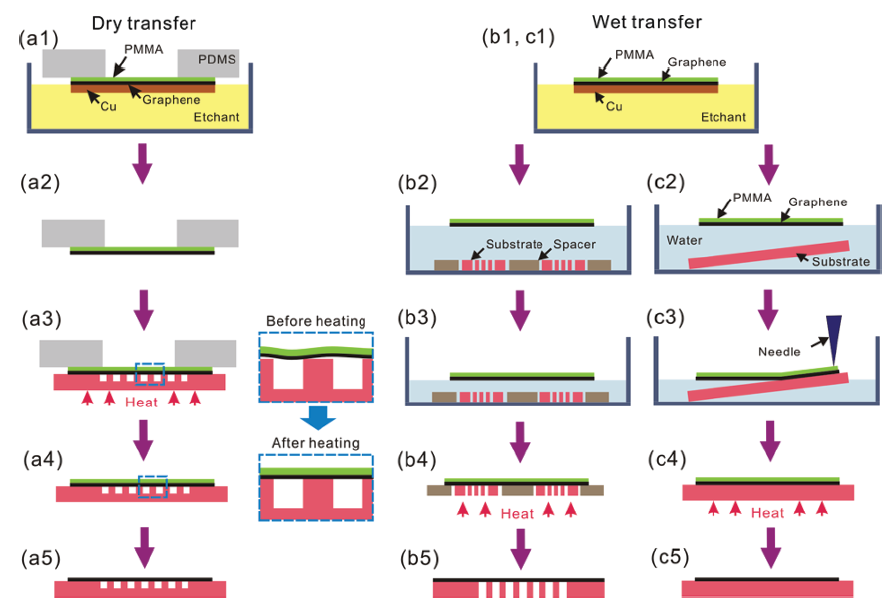
Figure 13. Schematic illustration of dry and wet transfer process. ( a1–a5 ) Dry transfer onto shallow depressions. Wet transfer onto ( b1–b5 ) perforated substrates and ( c1–c5 ) flat substrates. Reproduced with permission from [48].